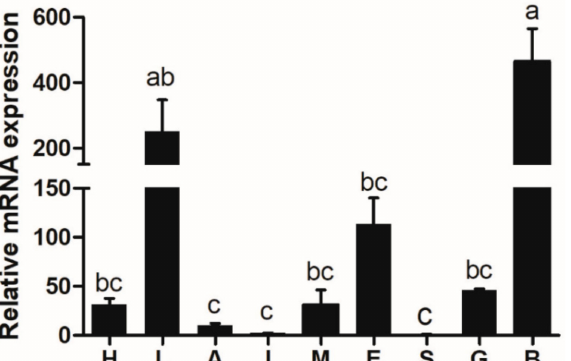
Figure 4. The transcriptional expression of elovl6 in di ff erent tissues of rainbow trout. Heart (H), liver (L), adipose tissue (A), intestine (I), muscle (M), eye (E), spleen (S), gill (G), brain (B). The expression of elvol6 in the spleen was selected as normalization. Data were presented as means ± S.E.M. (n = 3). Means that share the same superscript letter are not significantly di ff erent ( p >